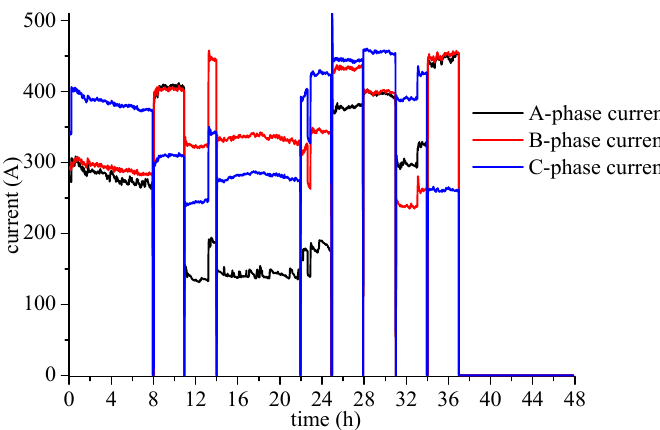
Figure 18. Unbalanced three-phase currents during the temperature-rise test.